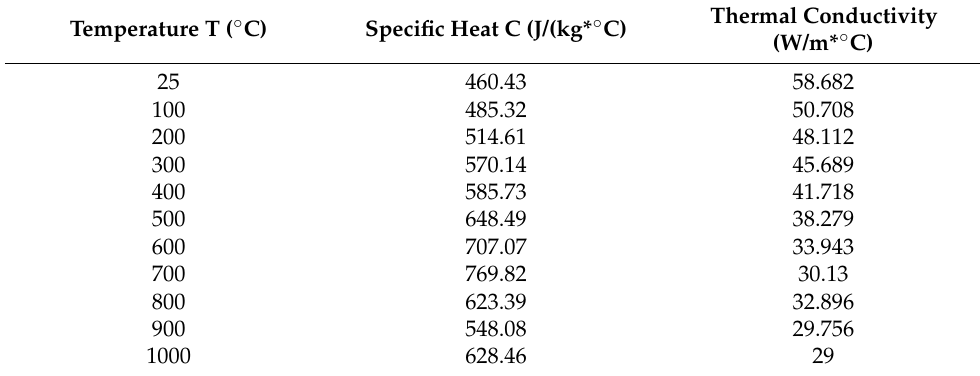
Table 2. Specific heat capacity and thermal conductivity of 42CrMo steel.